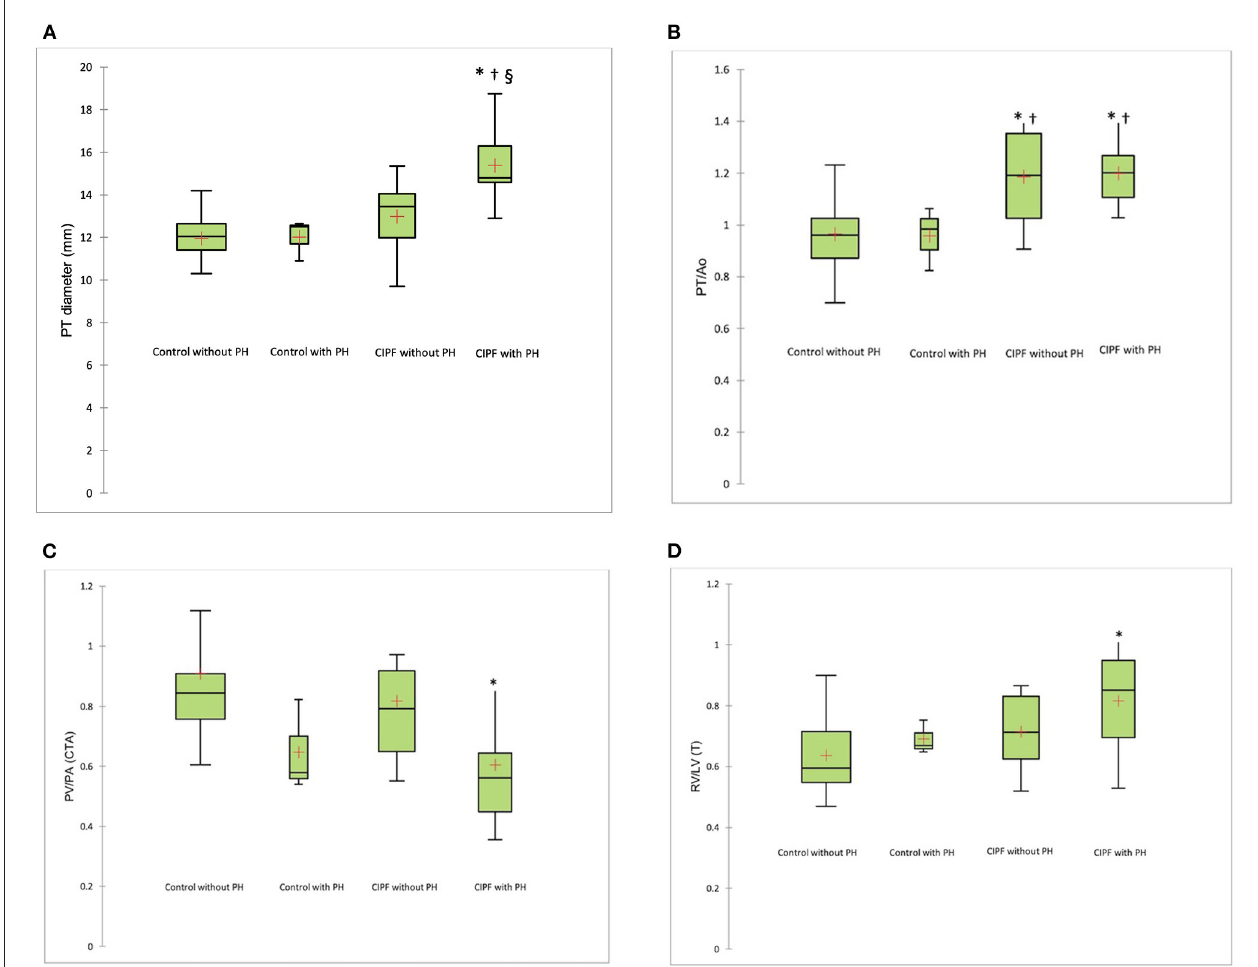
FIGURE 4 | Box plot illustrating PT (A) , PT/Ao (B) , PV/PA measured on CTA (C) , and RV/LV (T) (D) according to groups. The whiskers indicate the range of values. The box contains the 25th − 75th centiles. The line within the box indicates the median, and the cross indicates the mean. * p < 0.008, significantly different from control without PH; † p < 0.008, significantly different from control with PH; § p < 0.008, significantly different from CIPF group without PH. PT, pulmonary trunk; PT/Ao, pulmonary trunk-to-aorta ratio; PV/PA, pulmonary vein-to-right pulmonary artery ratio; CTA, computed tomographic angiography; RV/LV (T), right ventricle-to-left ventricle ratio measured on CTA acquired transverse plane; PH, pulmonary hypertension; CIPF, canine idiopathic pulmonary